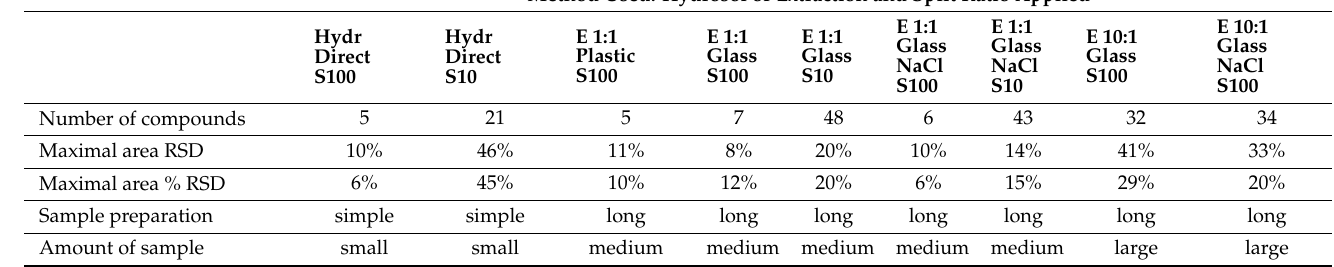
Table 2. Main characteristics of the methods used, that is, the number of detected compounds, maximal standard deviation of peak areas and area % for three repetitions of the same method, time consumption of sample preparation, and amount of sample used for analysis. Method Used: Hydrosol or Extraction and Split Ratio Applied *